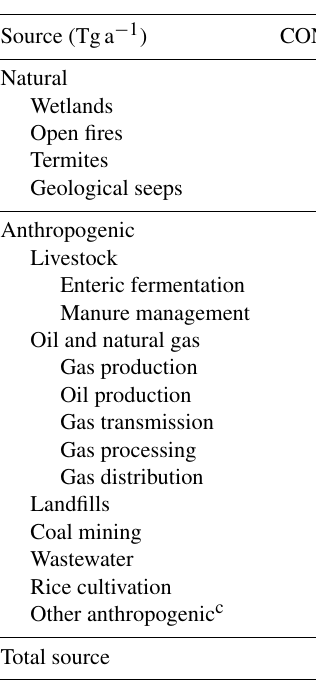
Table 1. Methane emissions used as prior 2010–2015 estimates.